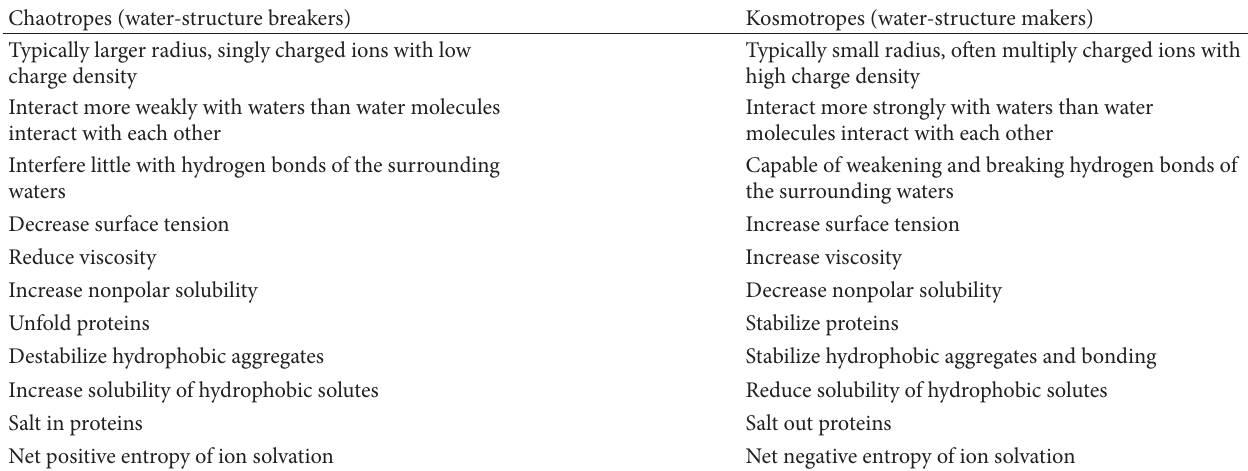
Table 4: Summary comparisons of chaotropic versus kosmotropic